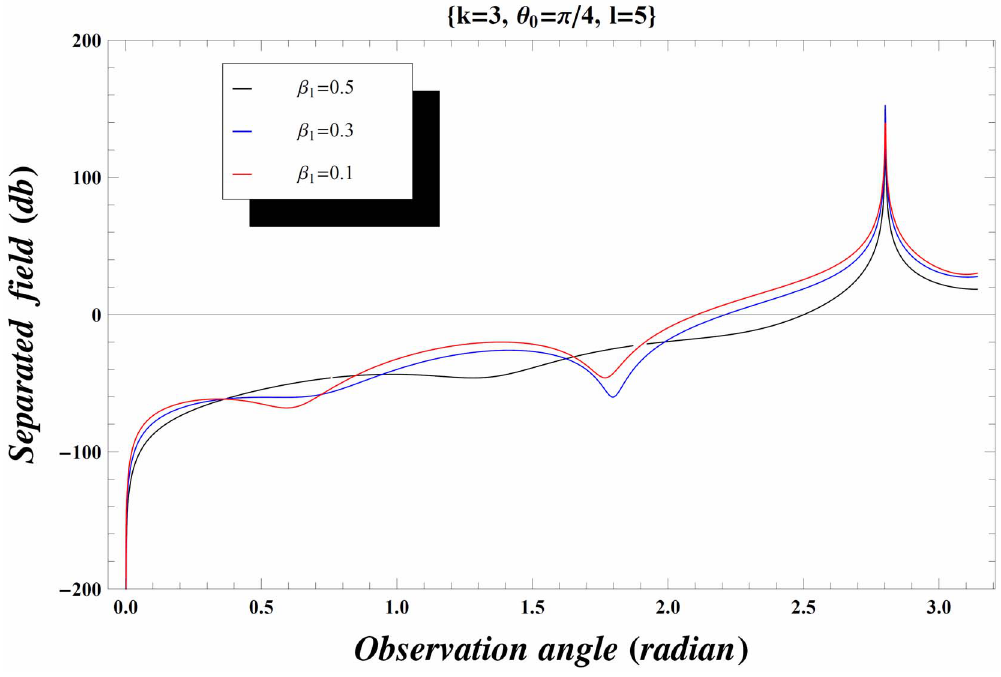
Figure 7. Separated field versus observation angle for different values of admittance parameter b 1 when k ~ 3 .